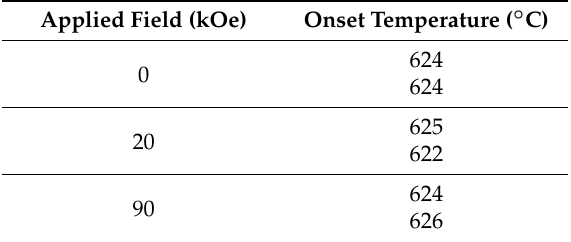
Table 1. Crystallization onset temperatures measured from DSC data shown in Figure